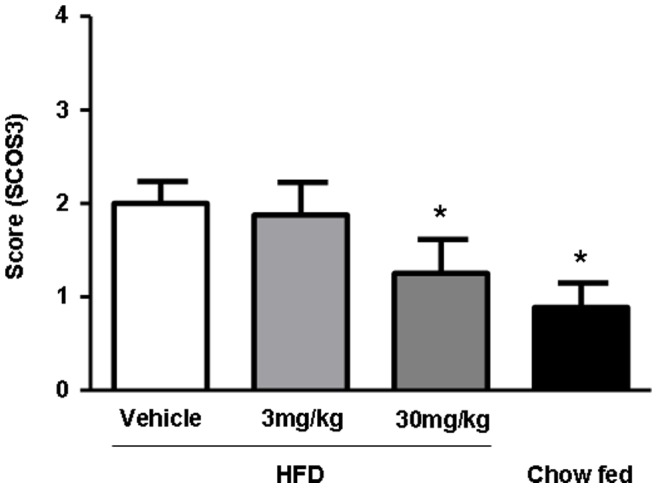
Effects of linagliptin on liver Suppressor of cytokine signaling 3 (SOCS3) protein expression.SOCS3 protein staining of liver specimens from diet-induced obesity (DIO) mice treated with vehicle, linagliptin 3 mg/kg/day (B), linagliptin 30 mg/kg/day (C) and chow-fed mice (D). Quantification of staining was performed by histologic scoring (n = 9 animals per group). Data are shown as mean ± SEM. *P<0.05.